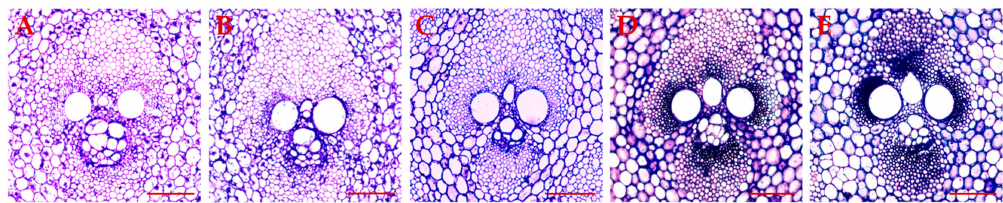
Figure 10. Transverse sections of vascular bundle in bamboo shoots with di ff erent heights. ( A ): 1.0 m shoots; ( B ): 2. 0 m shoots; ( C ): 4.0 m shoots; ( D ): 6.0 m shoots; and ( E ): 8.0 m. Scale bar: 100 µ m.